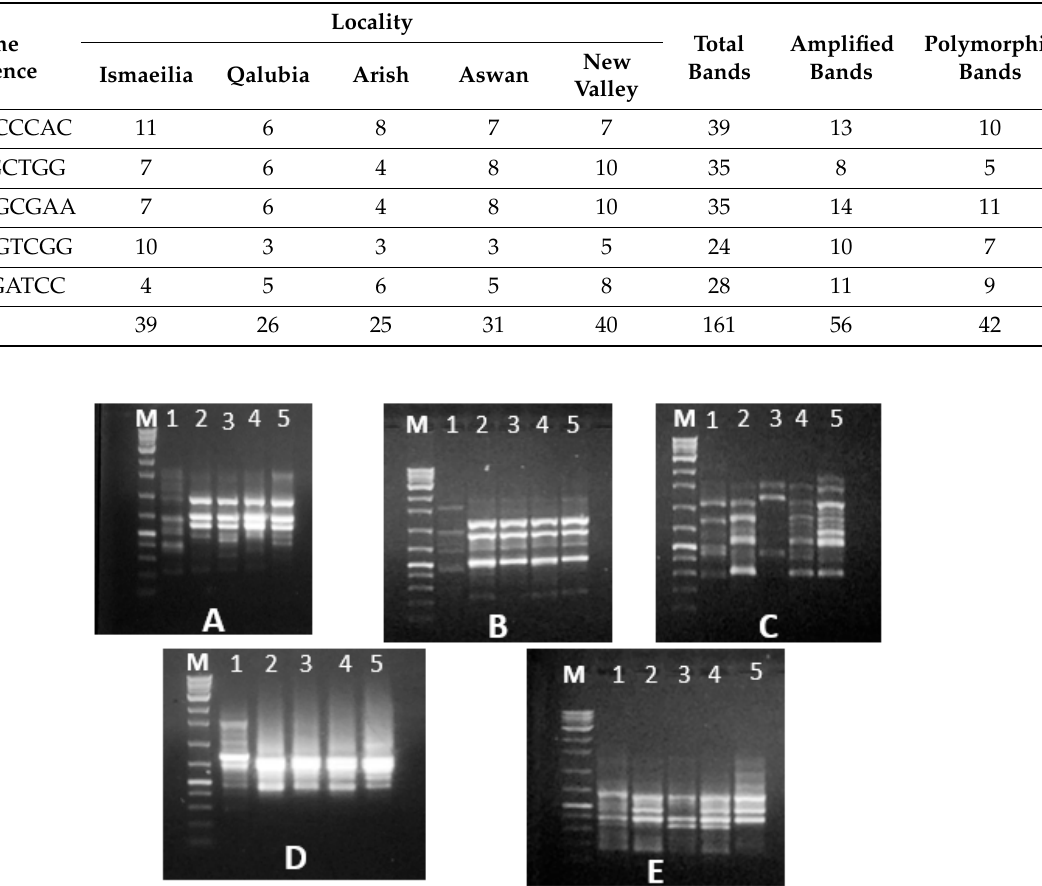
Figure 7. DNA fingerprinting of five RPW populations from five governorates (1, Ismaeilia; 2, Qaluobia; 3, Arish; 4, Aswan and 5, New Valley) revealed from five RAPD markers: ( A ) OPA 13; ( B ) OPA14; ( C ) OPA16; ( D ) OPA19; ( E ) OPA 20.